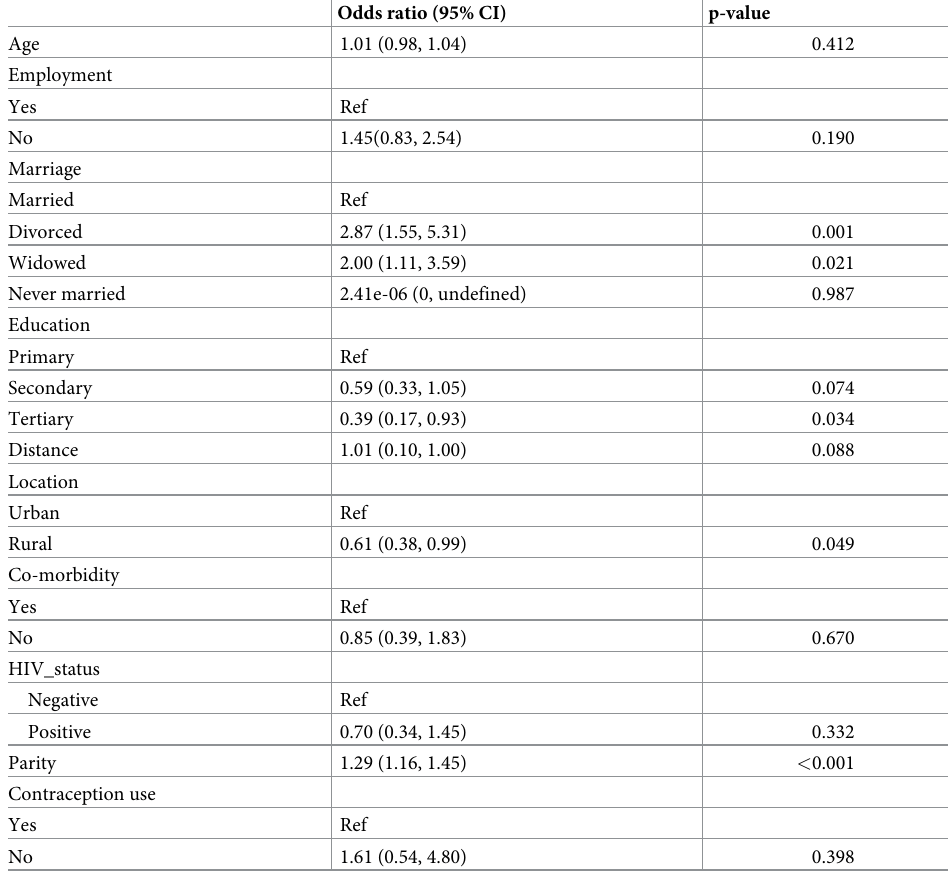
Table 4. Ordered logistic regression- factors explaining diagnosis (late presentation) (n =